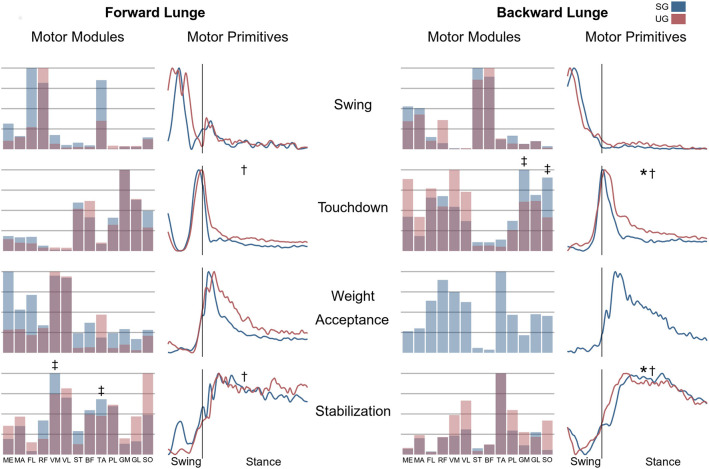
Differences for motor modules and motor primitives for the recognized synergies in the forward and backward lunges. Significant differences in the full width at half maximum of the motor primitives are denoted by asterisks (*), differences in the motor primitives center of activity by daggers (†). Double daggers (‡) denote post-hoc individual muscles differences in the motor modules.